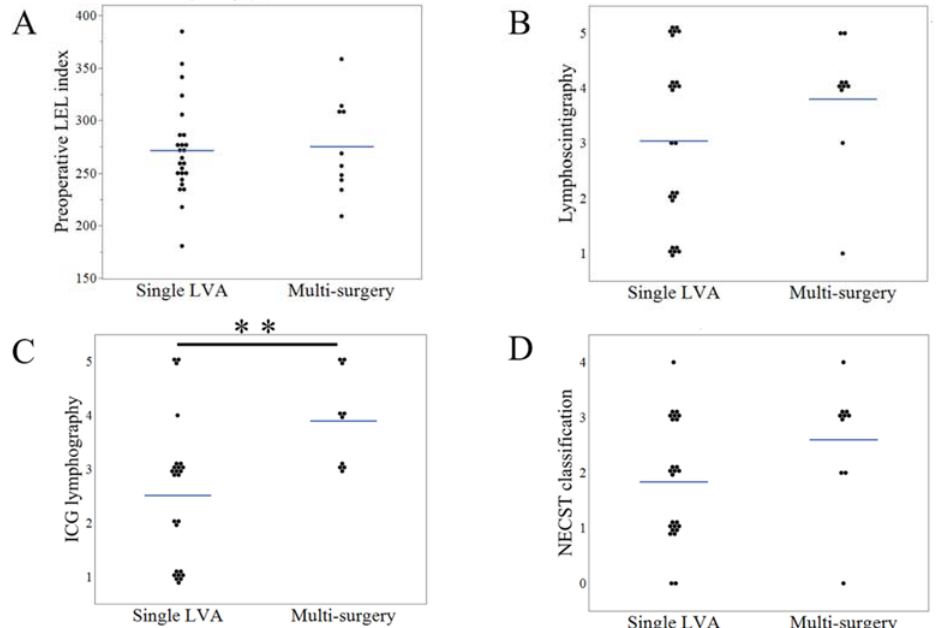
Figure 7. Comparison of clinical parameters in the single lymphatic venous anastomosis and multi-surgery groups. The comparison of preoperative lower extremity lymphedema (LEL) index ( A ), lymphoscintigraphy staging ( B ), ICG lymphography staging ( C ), and the normal, ectasis, contraction, and sclerosis type classification (NECST) staging ( D ), in the single LVA and multi-surgery groups. ** p < 0.01.